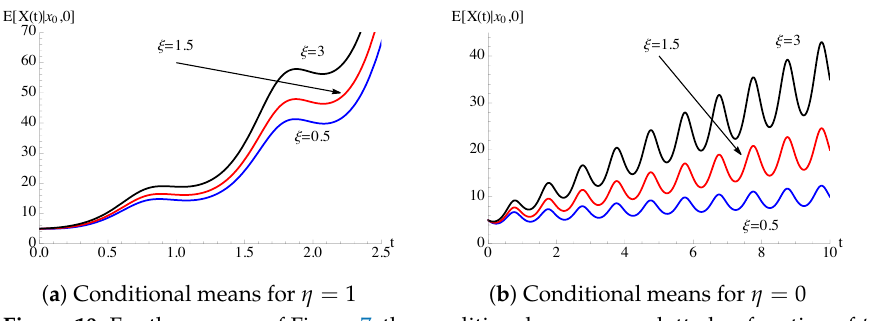
Figure 10. For the process of Figure 7, the conditional means are plotted as function of t for various choices of ξ .